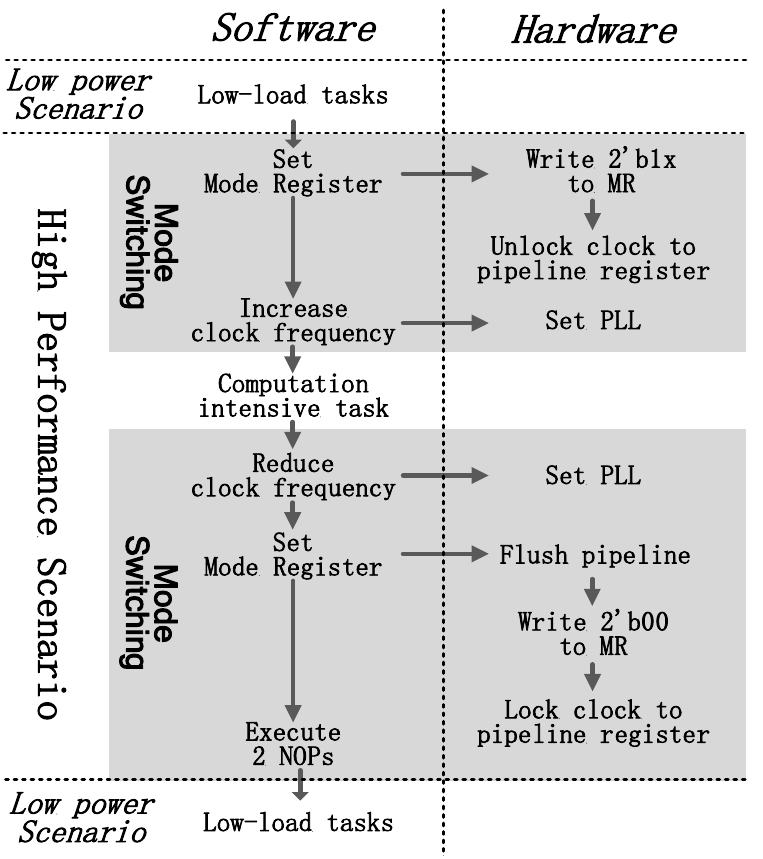
Figure 10. Software-based mode switching